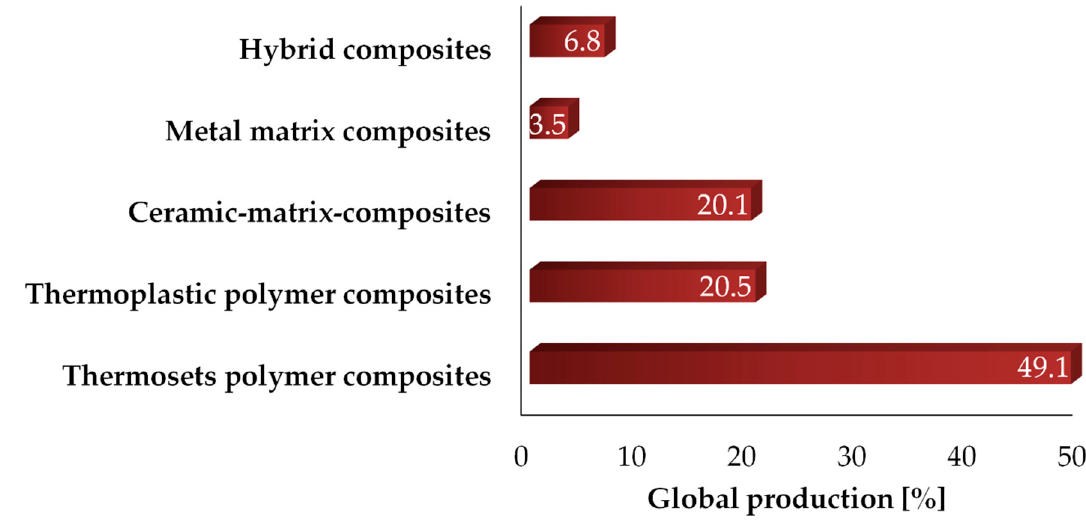
Figure 7. World carbon-based composite production in 2018, according to Sauer et al. [ 270] .